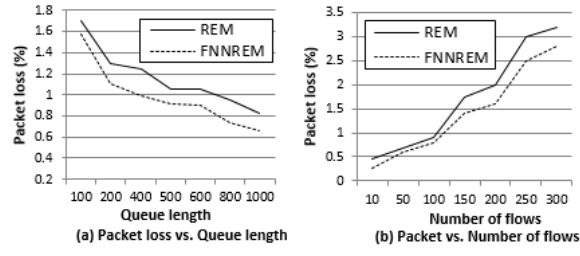
Figure 12. Packet loss rate of the active queue management mechanisms